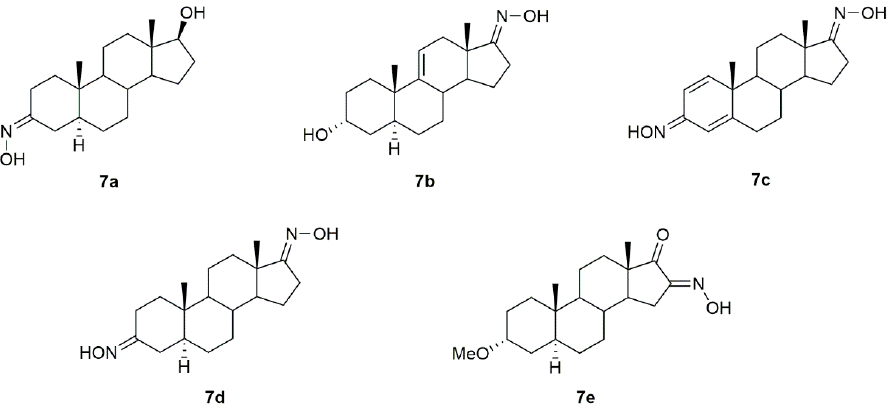
Figure 10. Steroidal androstane oxime derivatives with antibacterial and antifungal activity.